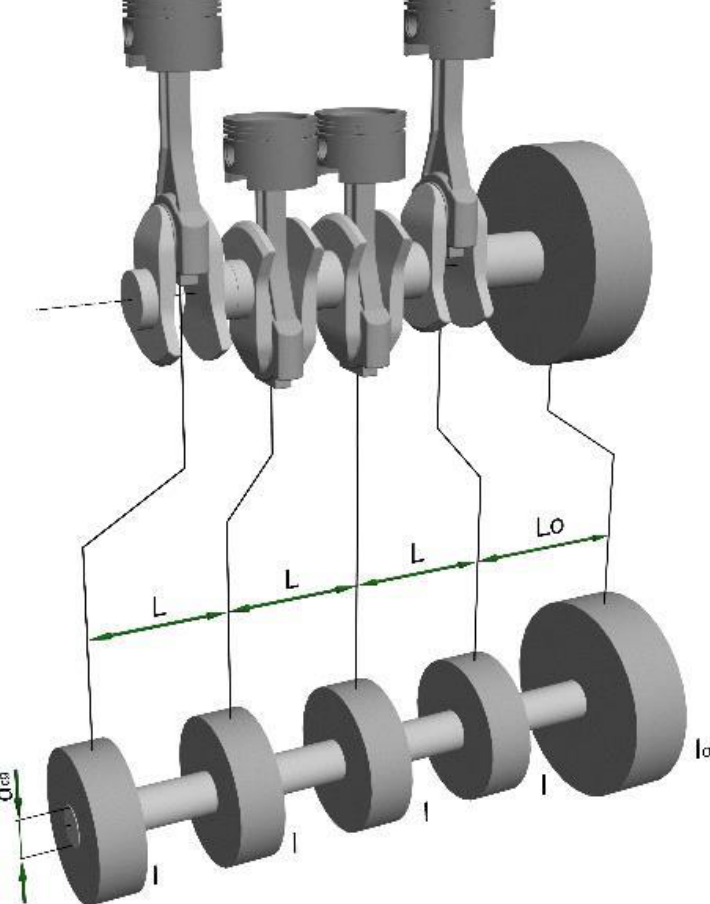
Figure 6. The actual and substitute model of a crank–piston system [8]; I—reduced mass of inertia of individual crank–piston systems, I 0 —reduced mass of inertia of the flywheel, L—reduced distances between the reduced masses of inertia for the crank–piston systems, L 0 —reduced distance between the reduced mass of inertia of flywheel and the last crank–piston system, d cp —reduced diameter of the crankshaft.